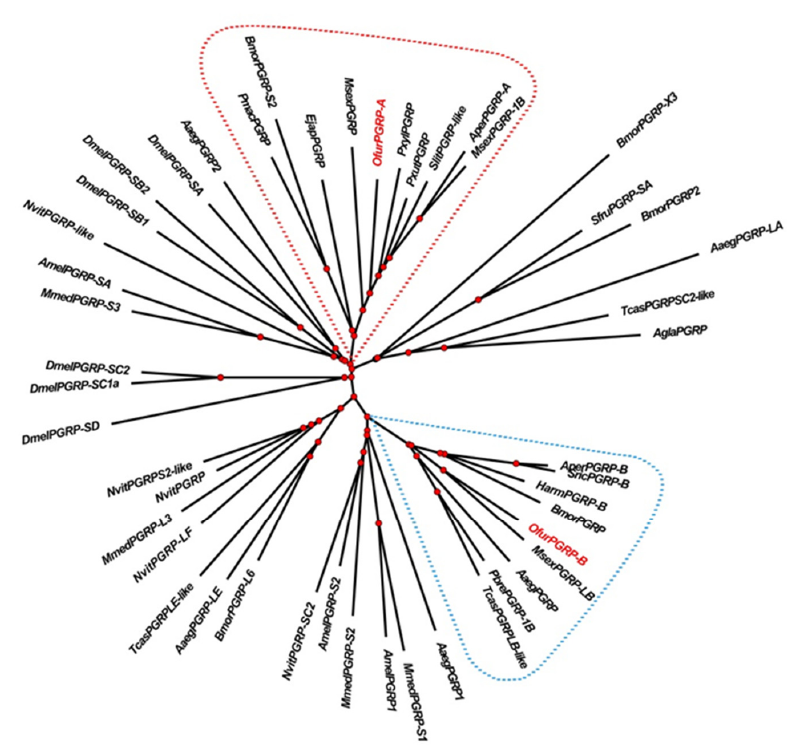
Figure 2. Phylogenetic tree of OfPGRP and PGRPs from other species. Bmor: Bombyx mori ; Sfru: Spodopterafrugiperda ; Aaeg: Aedes aegypti ; Tcas: Triboliumcastaneum ; Agla: Anoplophoraglabripennis ;